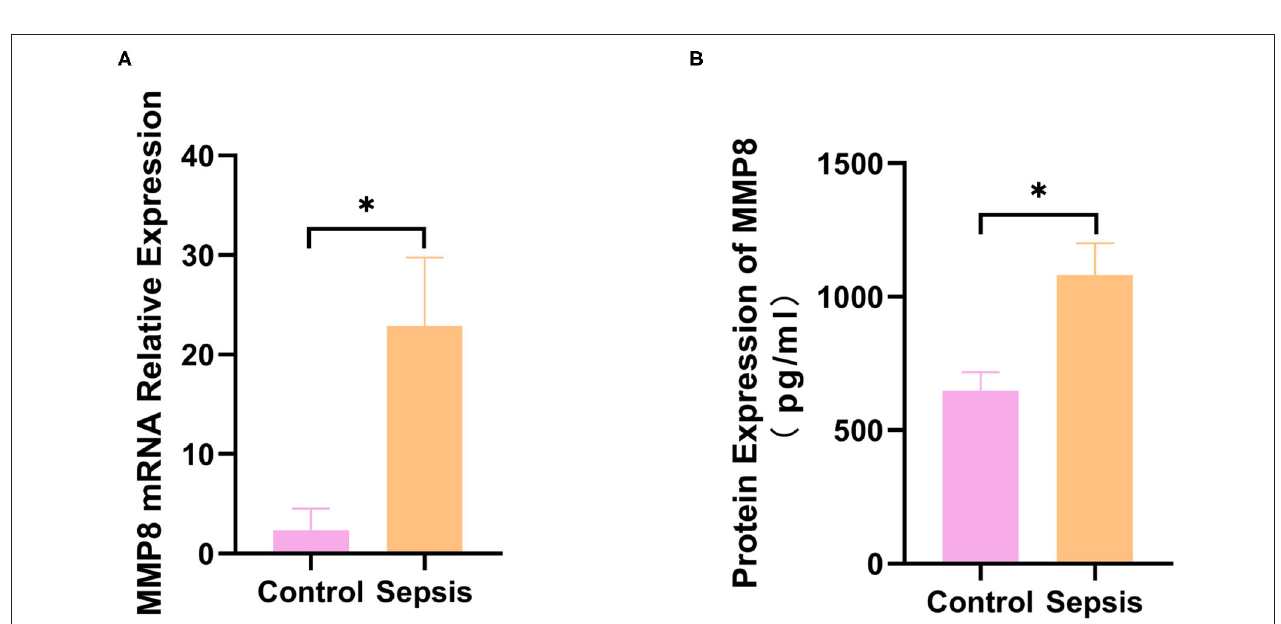
FIGURE 2 | Survival analysis of hub genes in GSE65682. (A–G) The survival curves of the 7 hub genes in GSE65682. Patients with high expression of FOLR3 and OSCAR had a better prognosis than low expression of these genes. Patients with low expression of MMP8 and ARG1 had a better prognosis than high expression of these genes.